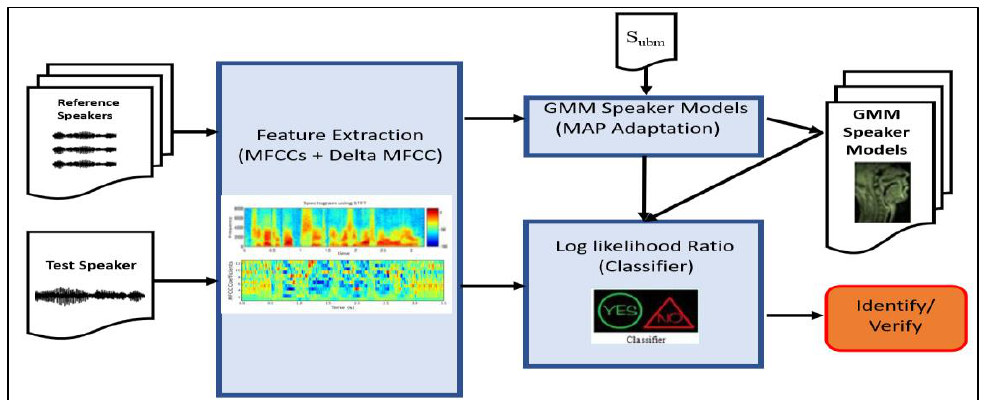
Figure 4. Algorithm flow chart GMM speaker model.